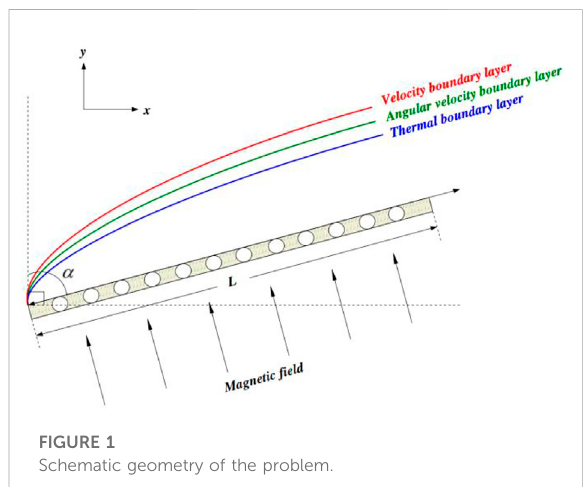
FIGURE 1 Schematic geometry of the